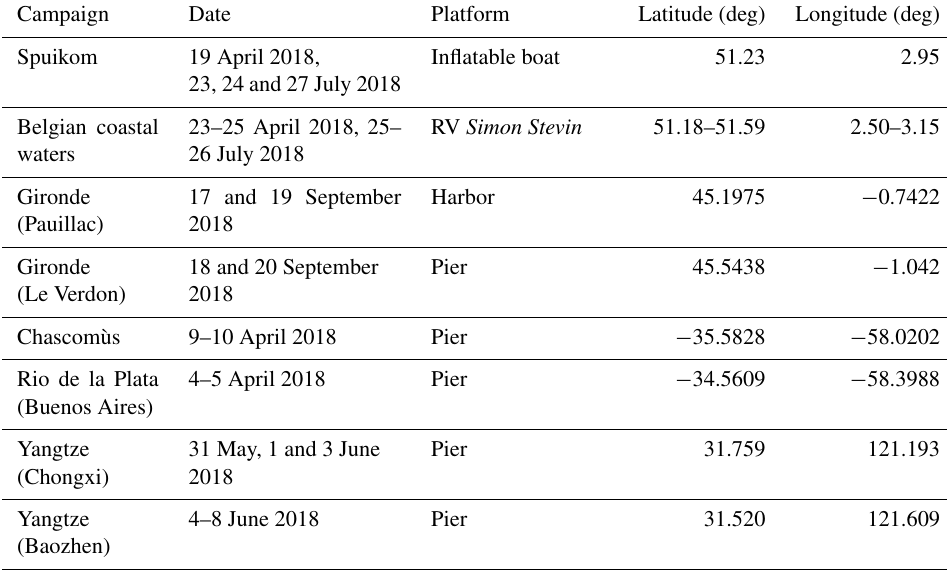
Table 1. Date, location, and platform of the